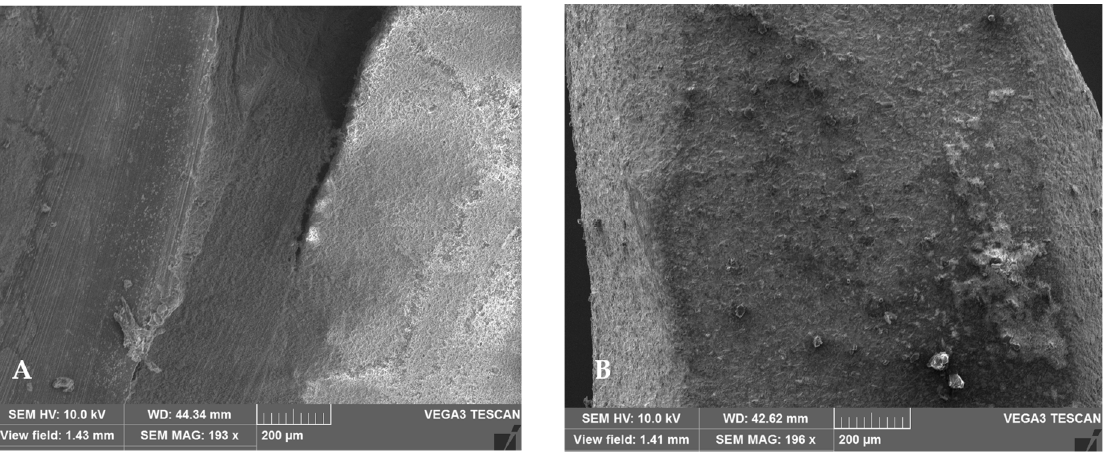
Figure 10. Scanning-electron-microscope image of ( A ) Sectioned root canal, and ( B ) displaced post, at 200× magnification, showing cohesive failure mode in Group 2 (CMTPCs) sample at root/post interface.